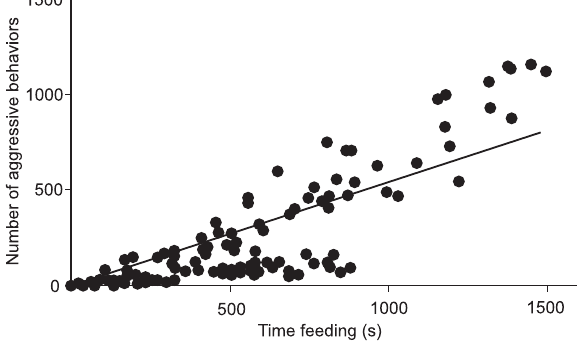
Figure 2. Positive correlation between the time spent feeding and the exhibition of aggressive behaviors by the hummingbirds. For this analysis, we included the time spent feeding by all hummingbird species in all sugar concentrations, and we summed the aggressive behaviors “expelling”, “fighting”, “frightening”, “expel attempt”, “alert” and